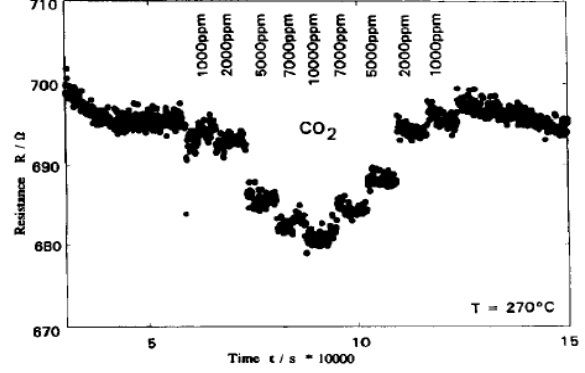
Figure 12. response of the SnO at 270 °C. Figure adapted with permission from